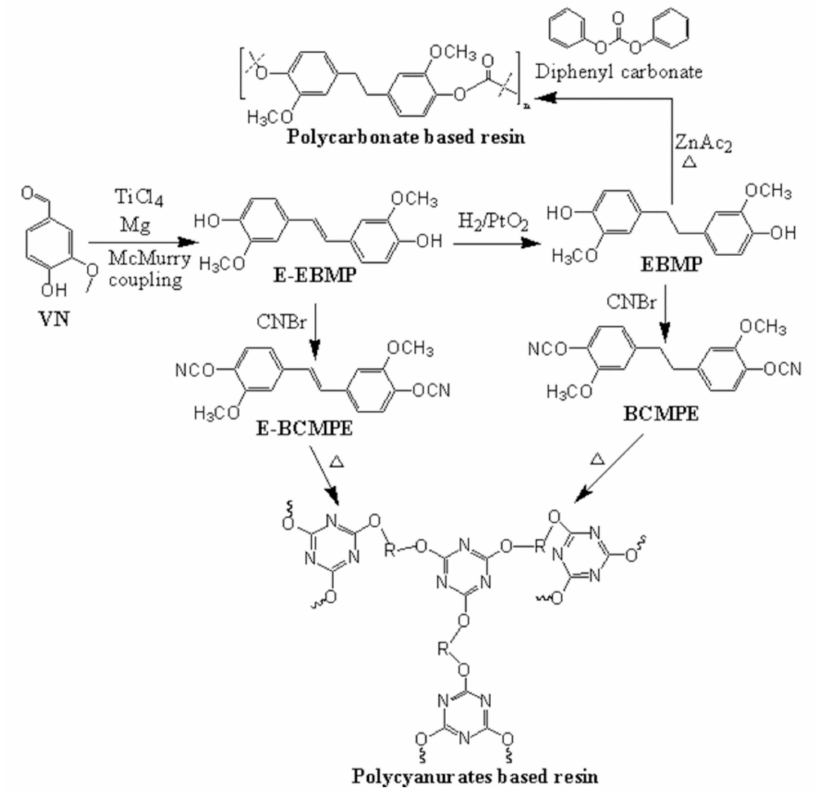
Figure 7. An illustration schematic reaction of cyanate-based monomers, polycyanurates, and polycarbonate-based